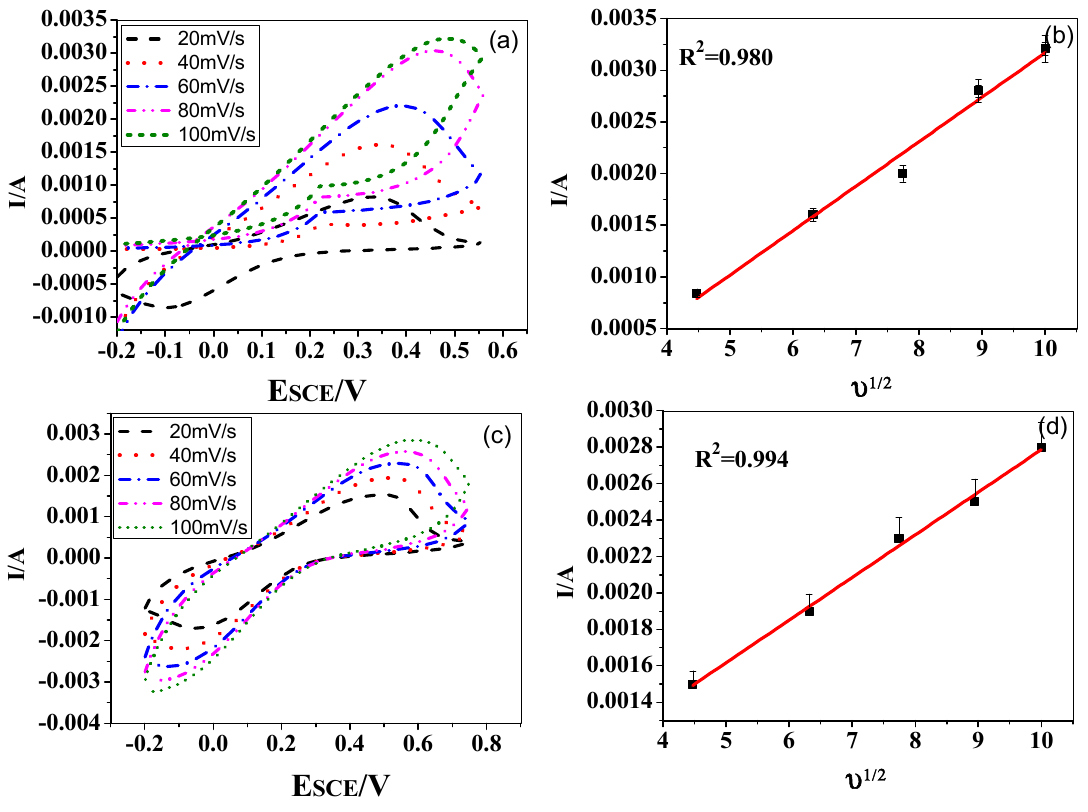
Figure 2. CV of ( a ) PACHA ( c ) PANI at different scan rates in 1.4 × 10 − 6 M H 2 O 2 ; ( b , d ) the dependence of the anodic peak current on the square root of scan rates.